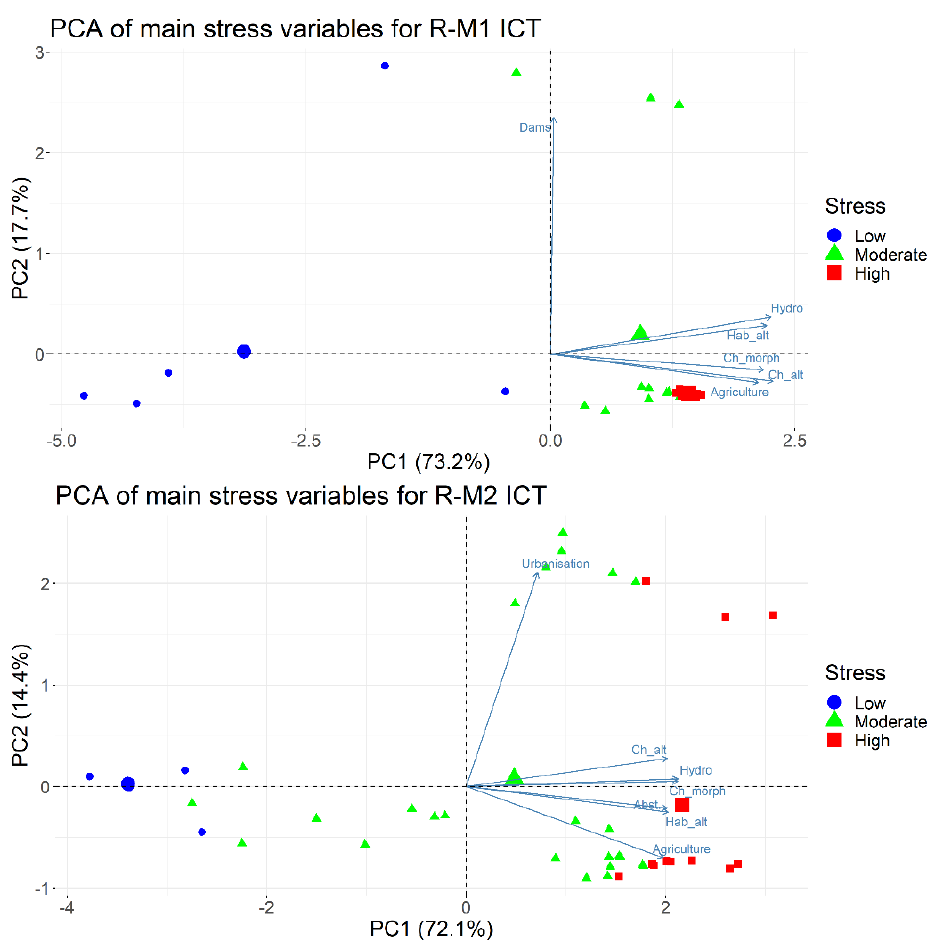
Figure 7. PCA biplots for sites belonging to ICT R-M1 ( top ) and R-M2 ( bottom ). PC1 components indicate a strong gradient of hydromorphological stressors. Unstressed sites (red dots) are positioned on the left part of the plot which, means low correlation with the stressor gradient. Table 3. Quality class boundaries of the normalized IBMR defined for two MedGIG intercalibration river types (R-M1 and R-M2).